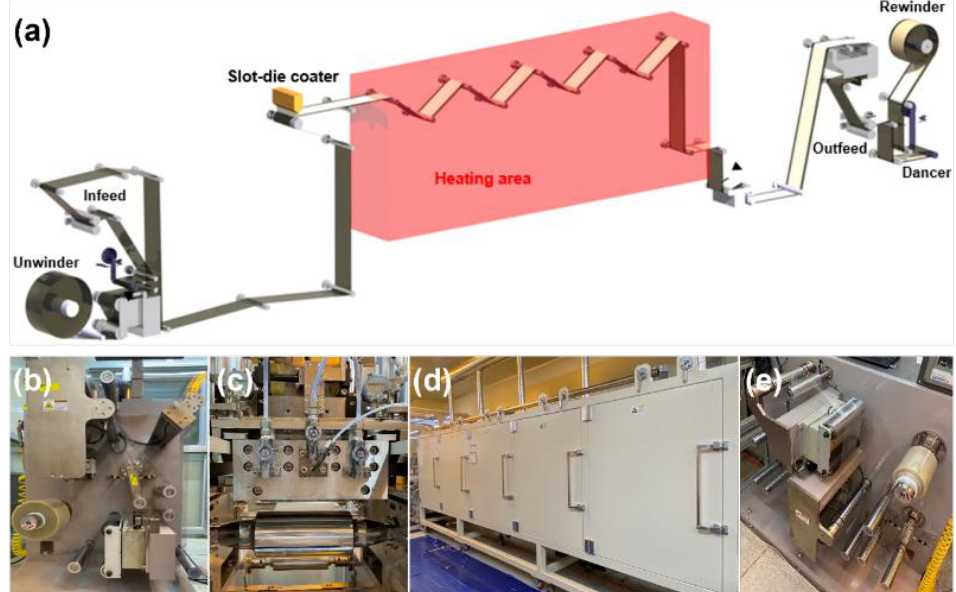
Figure 2. Roll-to-roll manufacturing systems: ( a ) schematic of roll-to-roll slot-die coating systems; ( b ) unwinding and infeeding section; ( c ) slot-die coater; ( d ) dryer; and ( e ) outfeeding and rewinding section.